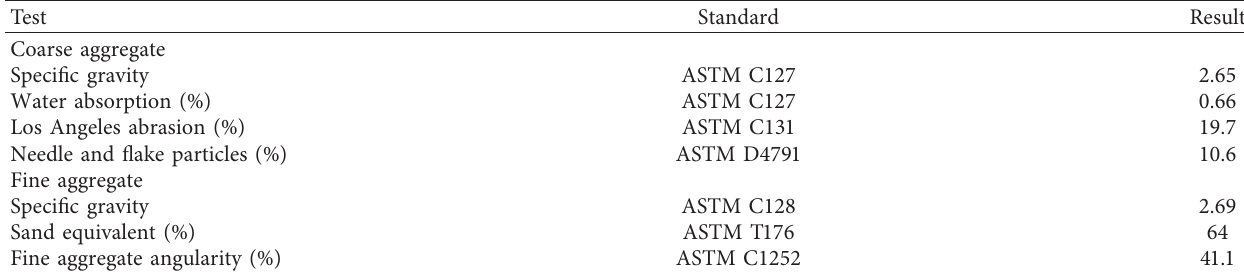
Table 2: Physical properties of aggregates.